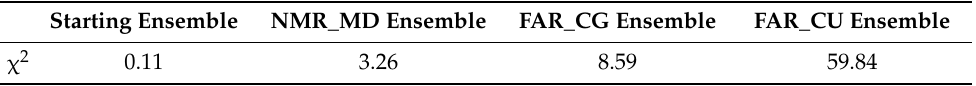
Table 1. Chi square goodness of fit for each SL2 ensemble’s NOE violations vs. measured upper